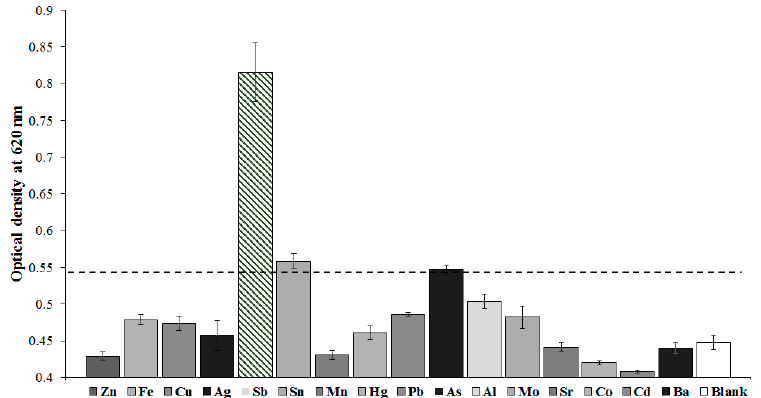
Figure 7. The values of A620 for GNP–PAOs after adding 50 ng / mL ions. The value of 0.55 indicates the absorbance of gold conjugate at 620 nm in the absence of antimony. The dashed line indicates the border between background staining (red, below this line) and reliable signal (optical density, blue, above this line). Concentrations of the corresponding ions used: Sr 2 + , Ba 2 + —10 mg / L; Mo 2 + , Mn 2 + , Zn 2 + , Hg 2 + , Co 2 + , Ag + , Cd 2 + , Cr 3 + , As 3 + , Cu 2 + , Pb 2 + , and Fe 3 + —1 mg / L. All experiments were undertaken in three replicates.